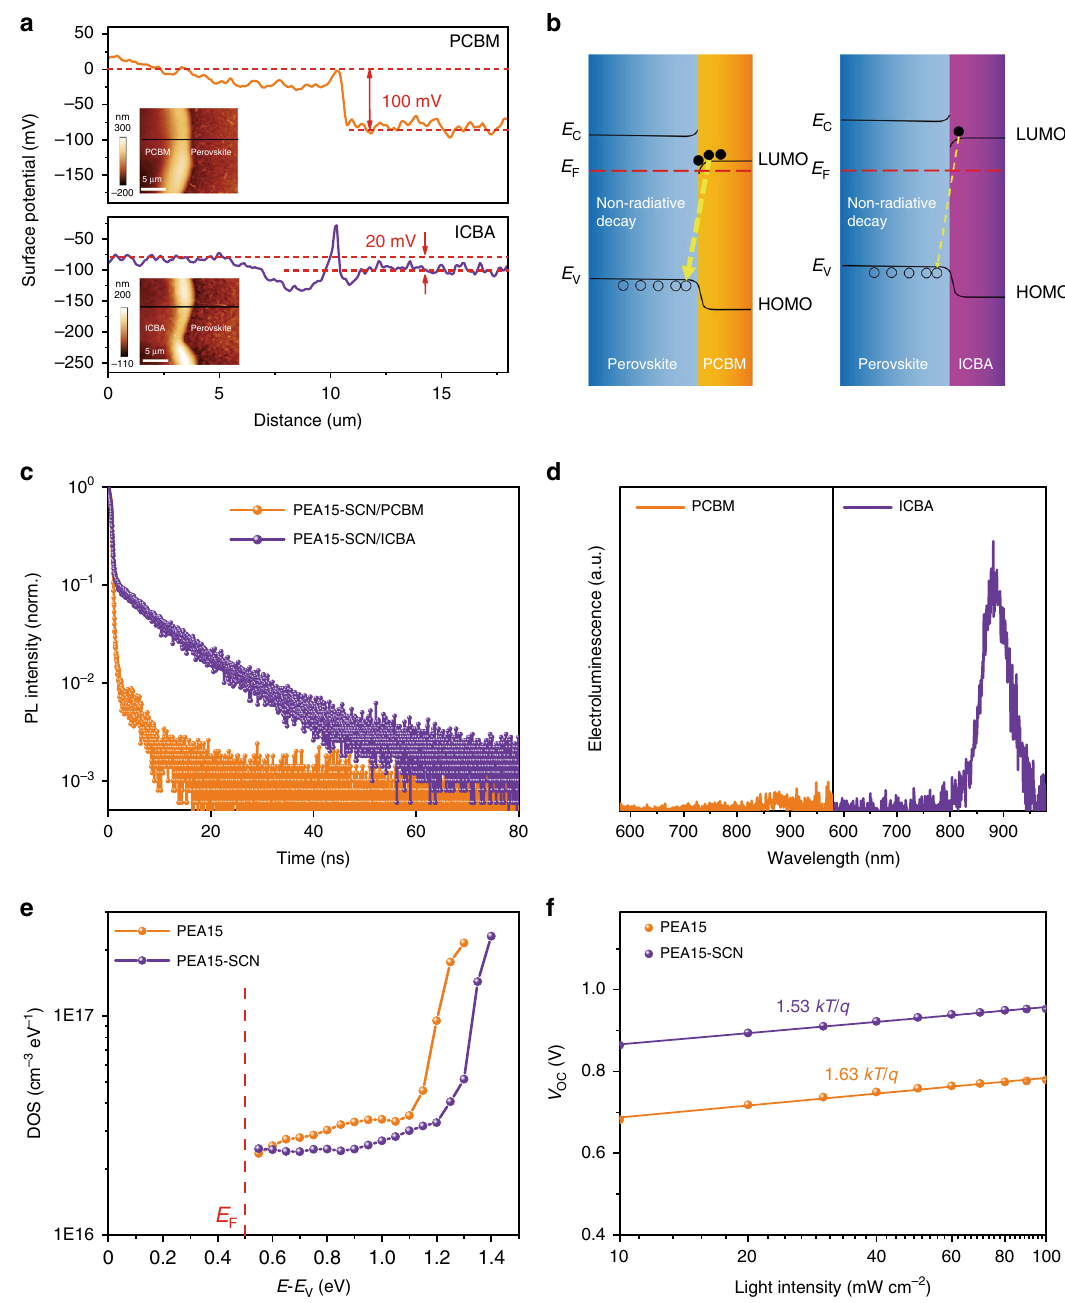
Fig. 4 Recombination and defect density characterization. a Surface potential distribution of PEA15-SCN/PCBM and PEA15-SCN/ICBA from SKPM measurement. The insert images are AFM topography images for the corresponding samples. b The schematic diagrams of interface recombination for the two samples. c Time-resolved photoluminescence kinetics at 840 nm for the ITO/PEDOT/perovskite/ETL fi lms after encapsulation. d Electroluminescence spectra of perovskite fi lms under bias voltage of 2 V. e The density of states in the bandgap calculated from TPV and TPC. f V OC versus illumination intensity for the